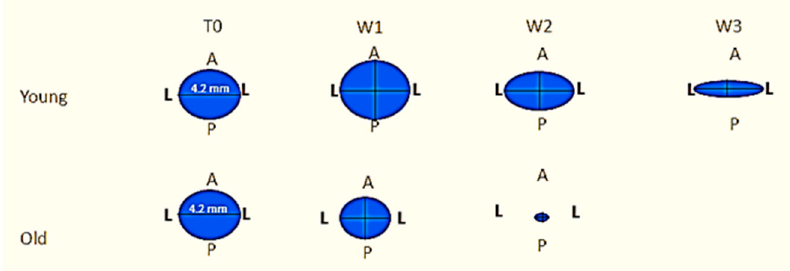
Figure 8. Wound closure dynamics.